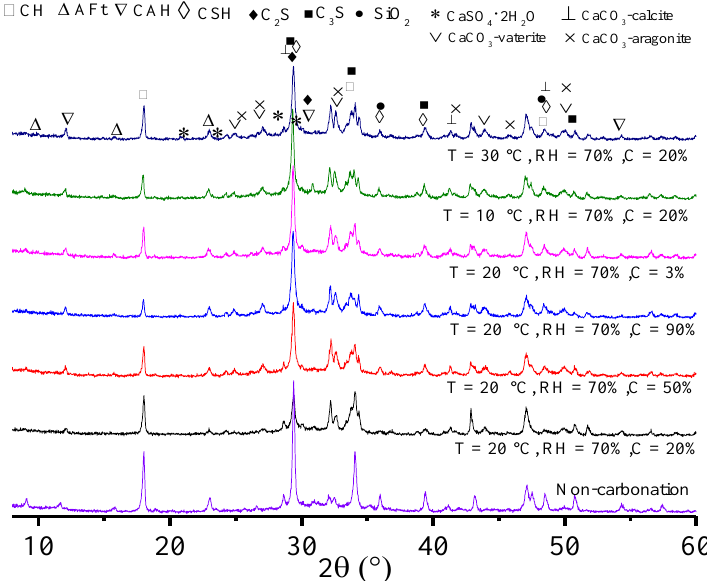
Figure 7. XRD spectra of the phase composition before and after carbonation.